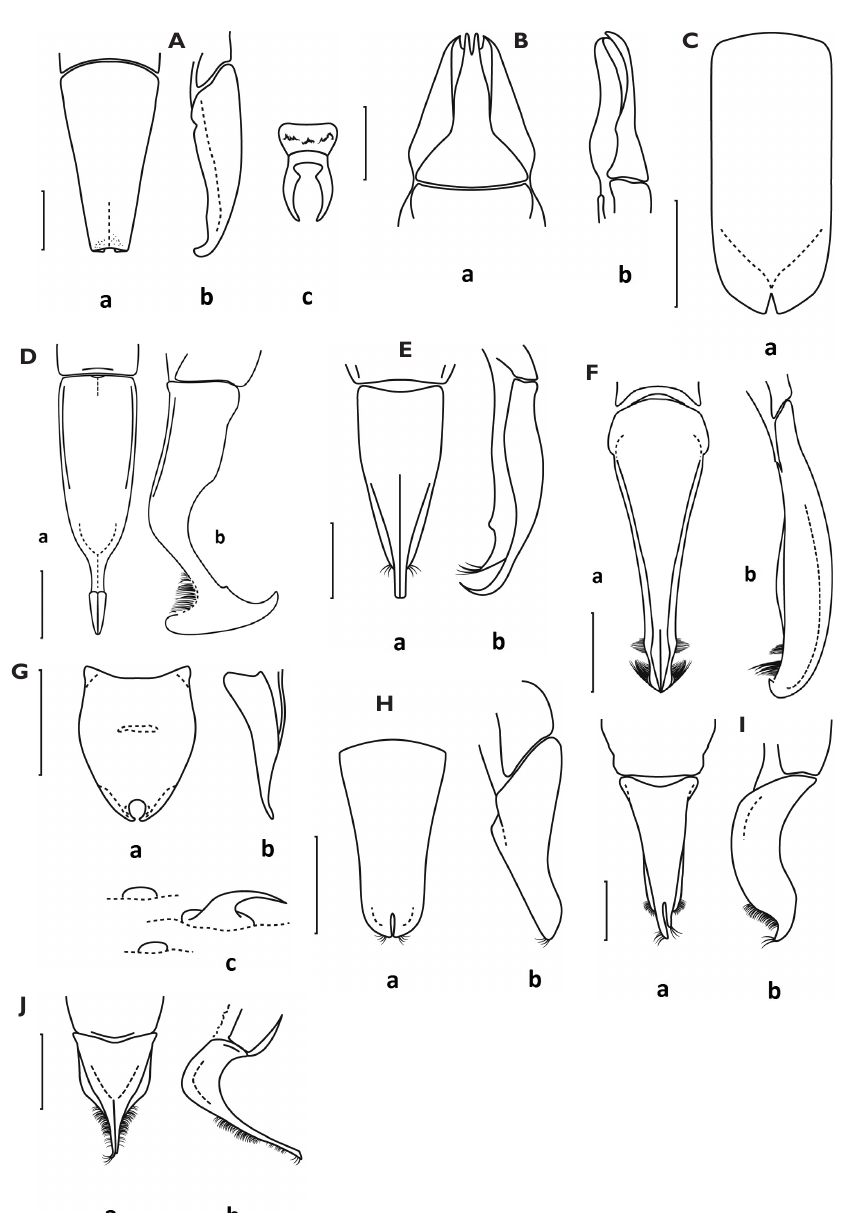
Figure 19. Schematic outlines of parameres ( a frontal; b lateral; c chitinous appendage). A Heteralleu- cosma insignis Antoine, 1989 B Niphetophora hildebrandti hildebrandti (Harold, 1878) C Paranelaphinis signata Antoine, 1988 D Molynoptera multiguttata Kraatz, 1897 E Pseudalleucosma machatschkei (Ruter, 1960) F Molynopteroides guttiventris (Moser, 1914) G Phaneresthes flavovariegata Kraatz, 1894 H Paral- leucosma glycyphanoides glycyphanoides (Moser, 1908) I Alleucosma ( Alleucosma ) viridula (Kraatz, 1880) J Alleucosma ( Eoalleucosma ) duvivieri (van der Poll, 1890) (Figure C after Antoine 1988; Figures G after Antoine 1989). Scale bar = 1